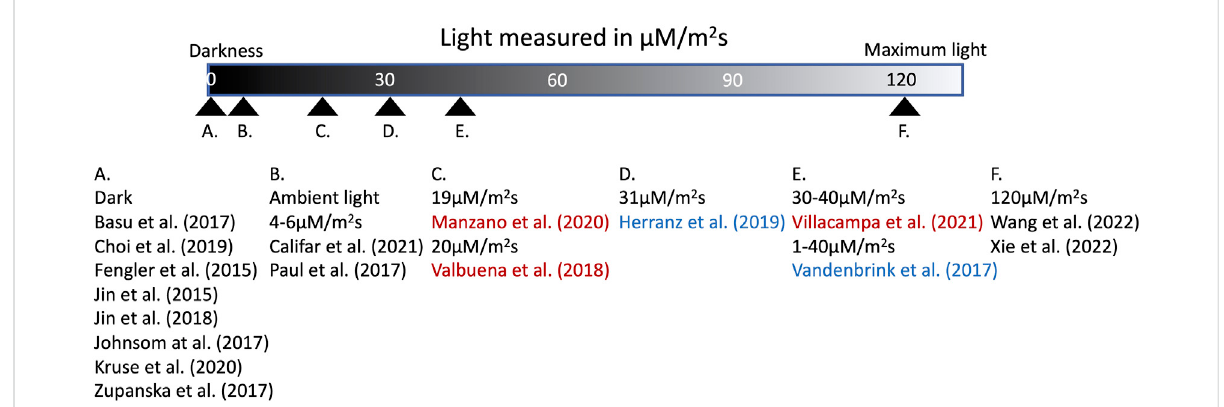
FIGURE 6 Summaryofthelightingconditionsfromrecentspace fl ightexperimentswithplants.Experimentsconducted usingredorbluelightarecolored